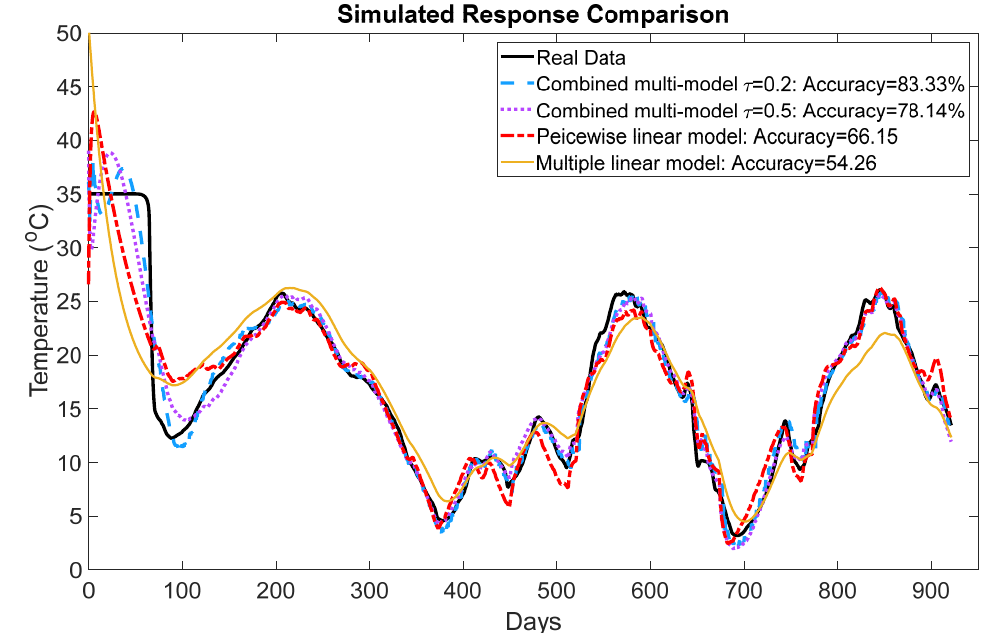
Figure 6. The performance of the identified models.